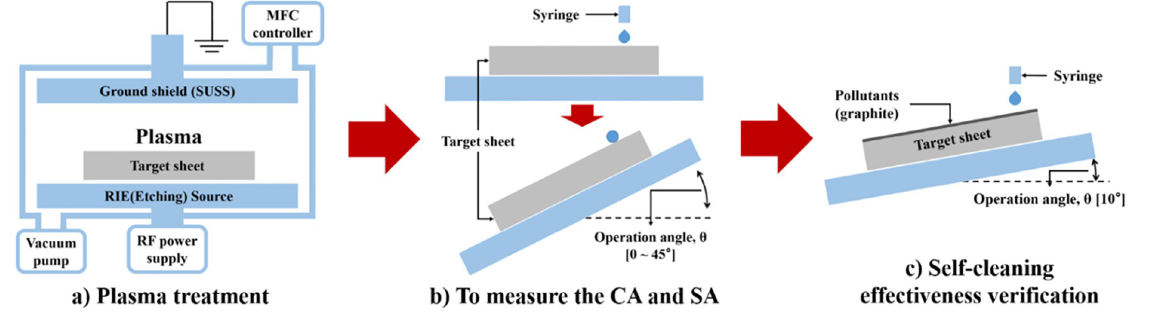
Fig 1. Schematic diagram of surface fabrication and experimental processes. (a) Plasma treatment of PTFE by controlling variables. (b) Measure the contact angle and sliding angle of the surface using a surface tension measuring equipment. (c) Check the self-cleaning effect of the specimen using graphite and water